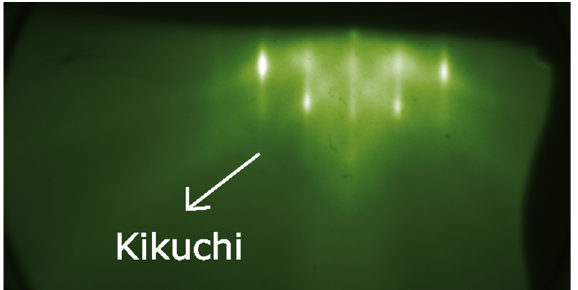
Figure 4. In situ RHEED measurements show the Laue circle and clear Kikuchi lines. In order to estimate the layer thickness, reflectivity measurements were